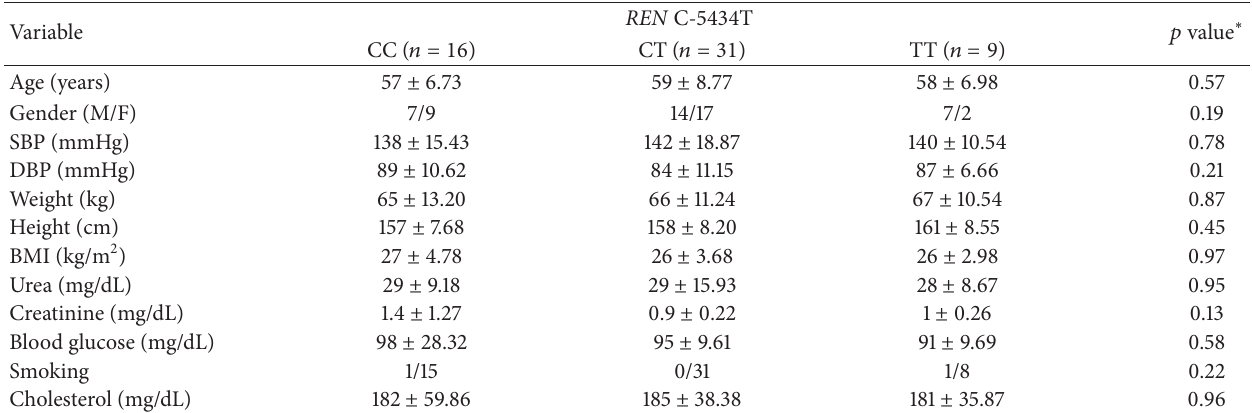
Table 1: Baseline characteristics of the